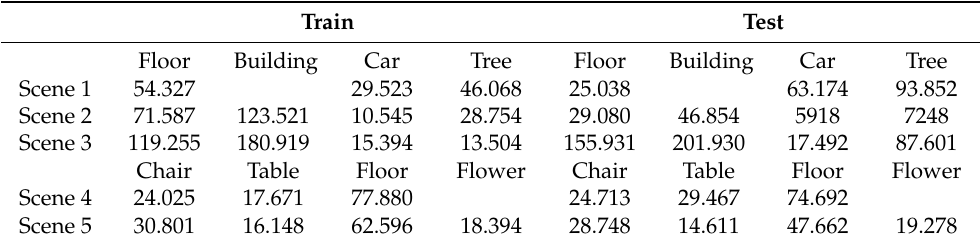
Figure 8. Scene 5 point cloud data. ( a ) Original point cloud of the training set; ( b ) ground truth of the training set; ( c ) original point cloud of the test set; and ( d ) ground truth of the test set. Red, green, yellow, and blue points represent plants, tables, floors, and chairs, respectively. Table 1. Statistics of experimental